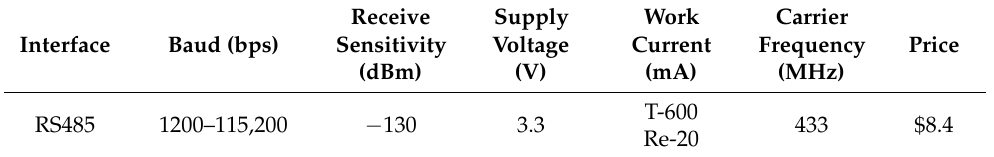
Table 2. Basic parameters of LoRa